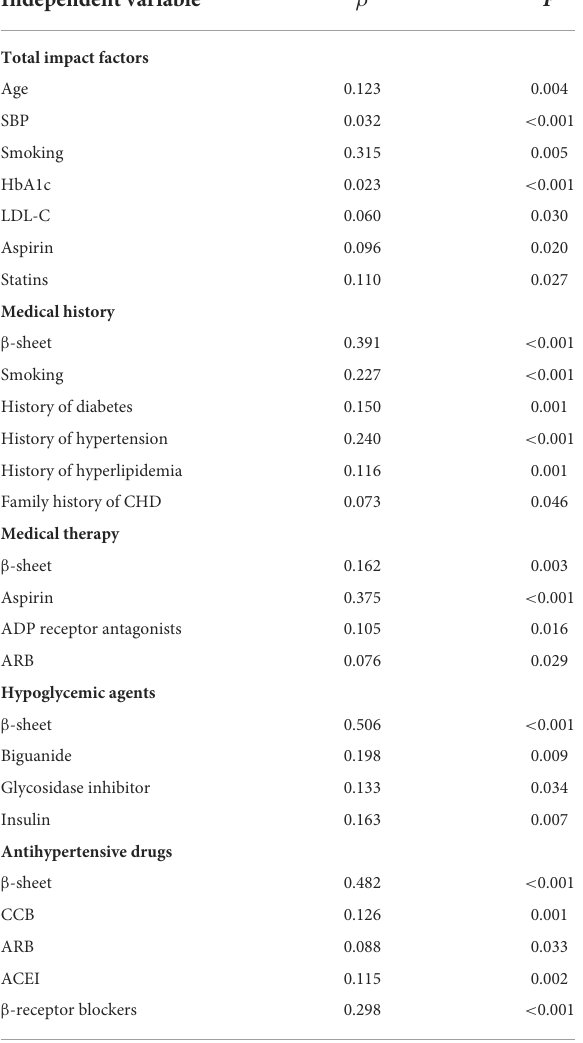
TABLE 3 Summary of multiple linear regression models for β -sheet level and Gensini score (multivariate). Independent